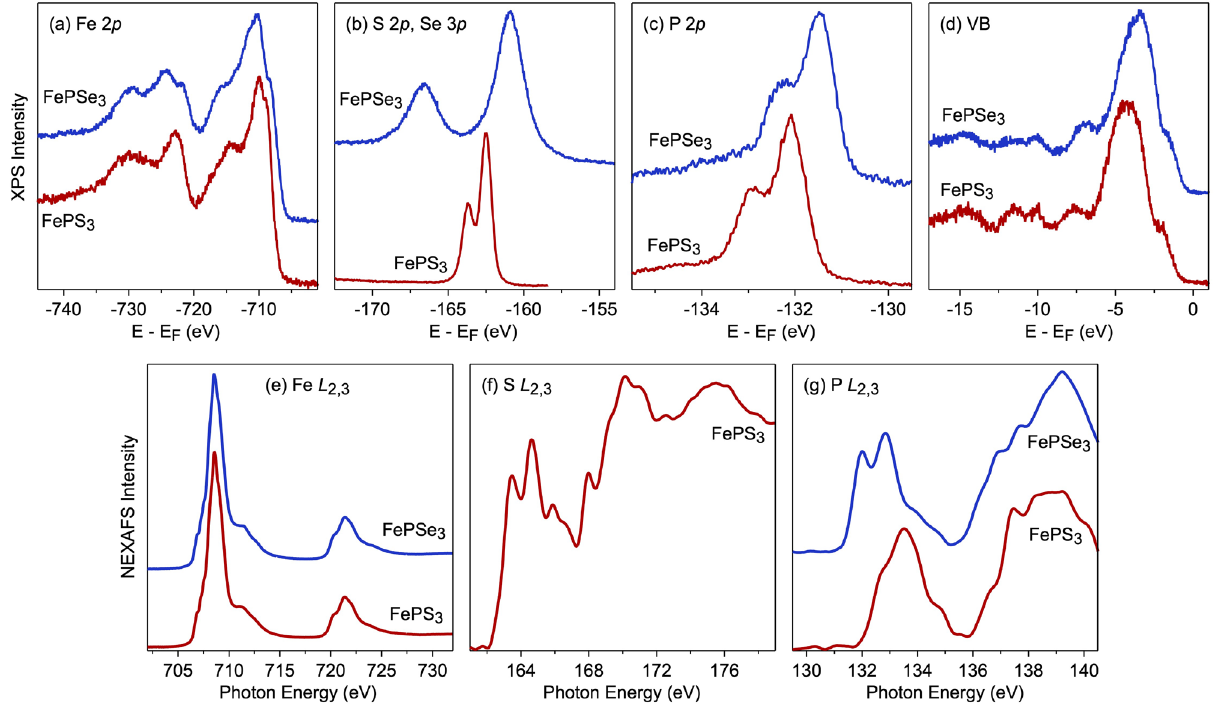
Figure 4. XPS spectra of FePX 3 collected at h ν = 1000 eV: ( a ) Fe 2 p , ( b ) S 2 p and Se 3 p , ( c ) P 2 p , and ( d ) valence band region. NEXAFS spectra of FePX 3 collected in the TEY mode: ( e ) Fe L 2,3 , ( f ) S L 2,3 , and ( g ) P L 2,3 . Images are created using Igor Pro (Version 9), https:// www. wavem etrics.